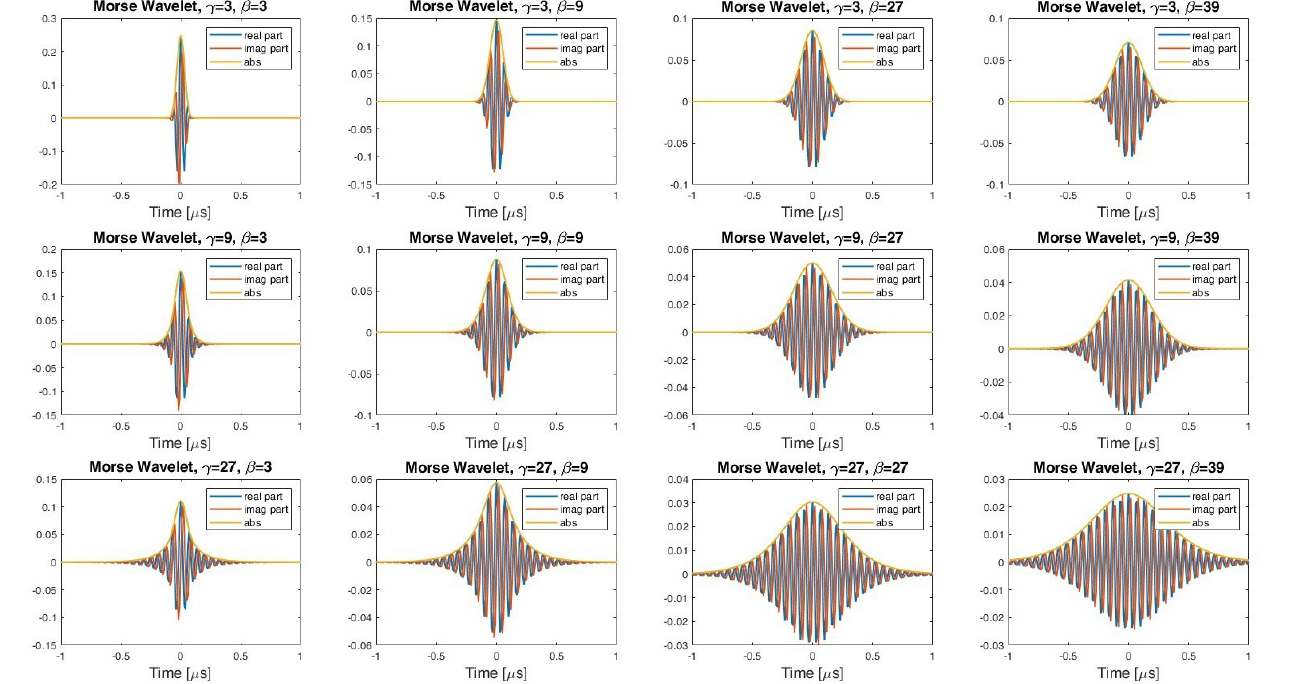
Figure A1. Morse wavelets corresponding to parameters from Table 3 for selected wavelet center